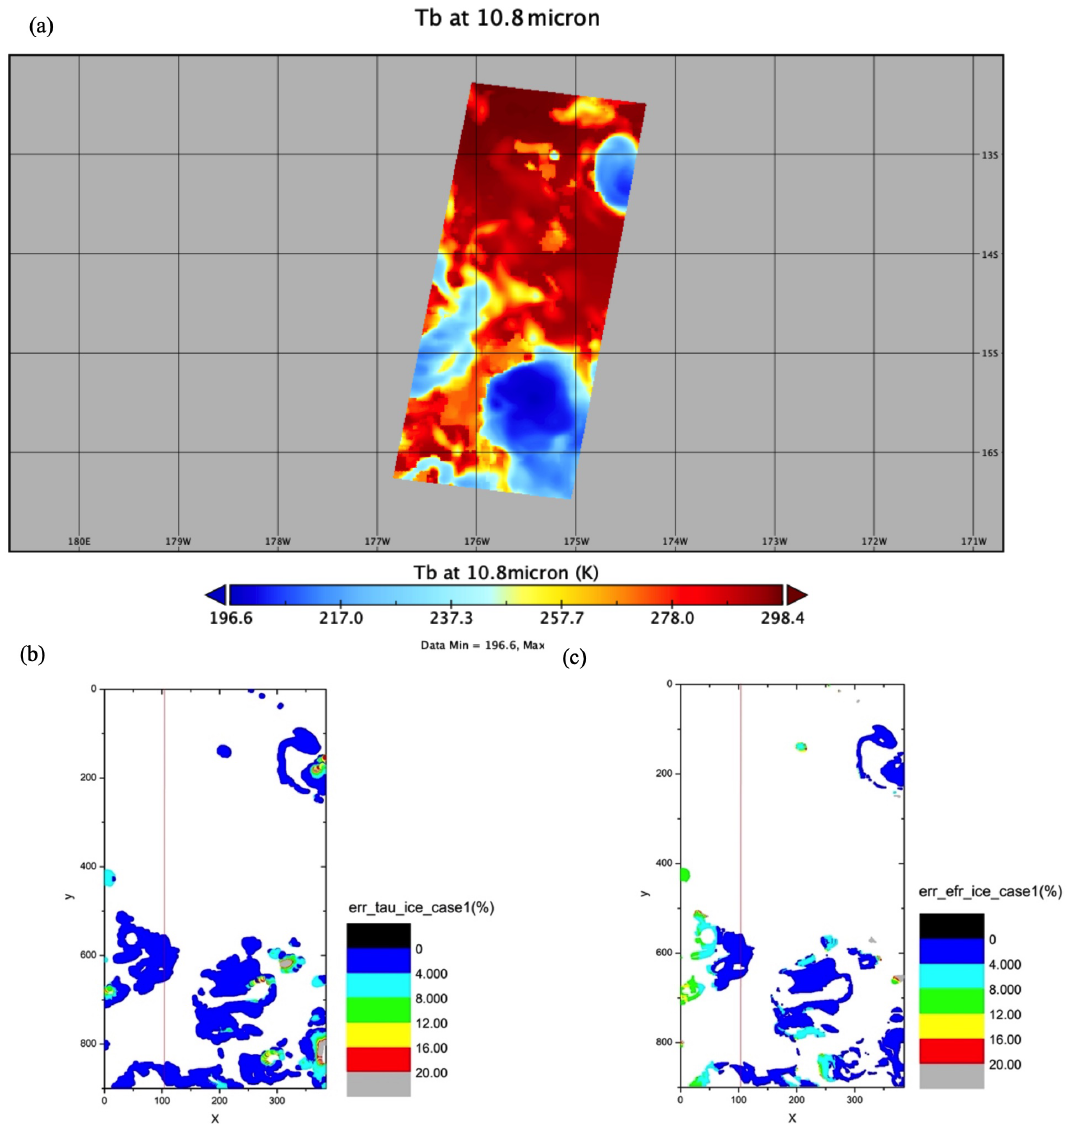
Figure 16. NICAM/Joint-Simulator data for deep convective clouds. (a) Brightness temperature at 10.8µm (band 6 of MSI), (b) error distribution of COT, and (c) error distribution of CDR. x and y in (b) and (c) show the pixel number in the swath or track direction. The red line in (b) and (c) stands for the location of the